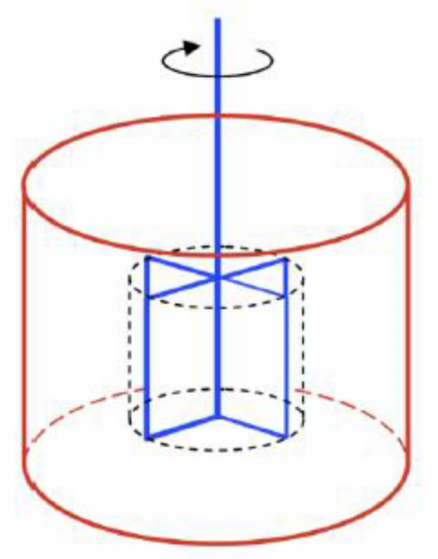
Figure 3. Central shape of ICAR rheometer [15].